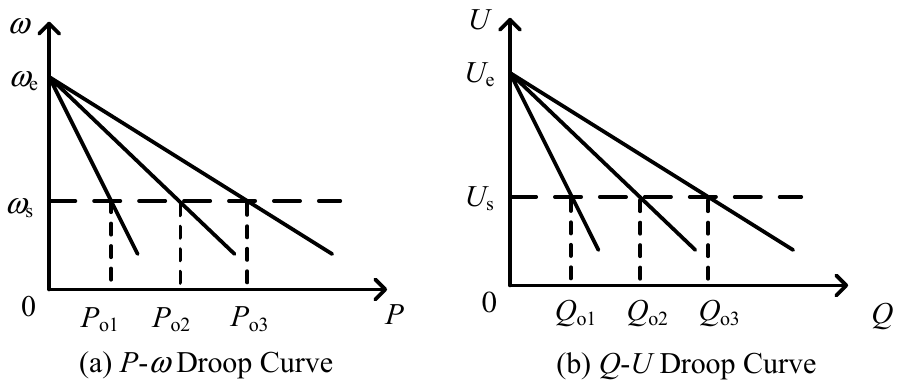
Figure 3. Schematic diagram of the droop curve: ( a ) P- ω droop curve; ( b ) Q-U droop curve. In Figure 3, ω e and ω s are the intercept frequency and steady-state frequency. U e and U s are the intercept voltage and steady-state voltage. The droop scheme presented in Equation (1) is called the P - ω and Q - U droop scheme [25,26]. Further, the P - U and Q -